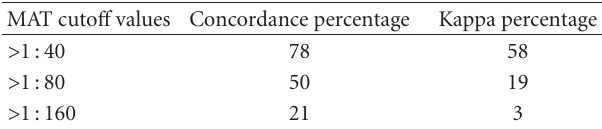
Table 5: Concordance percentage between the 2 diagnostic tech-